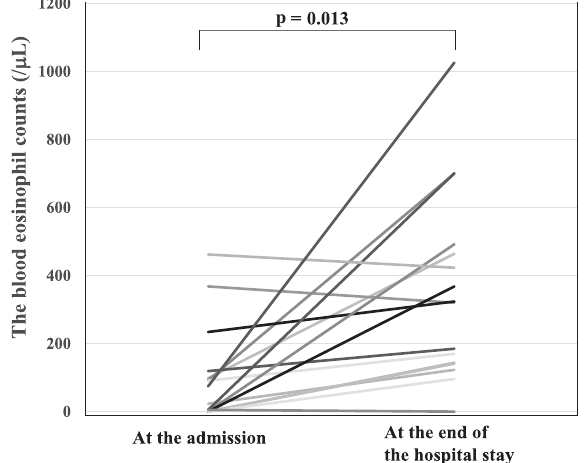
Figure 2. P eripheral blood eosinophil co u nts at admission and at the end of the hospital sta y . P eripheral blood eosinophil co u nts w ere meas u red in 20 s u bjects at hospital admission, and in 16 s u b- jects at the end of the hospital sta y